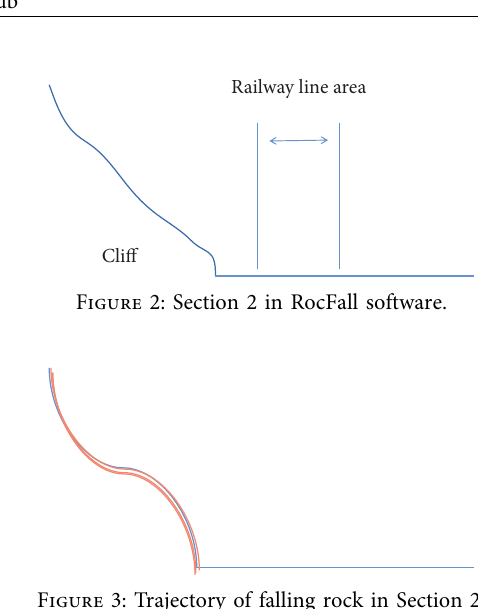
4: Bounding height envelope of falling rocks in Sections 1–5.